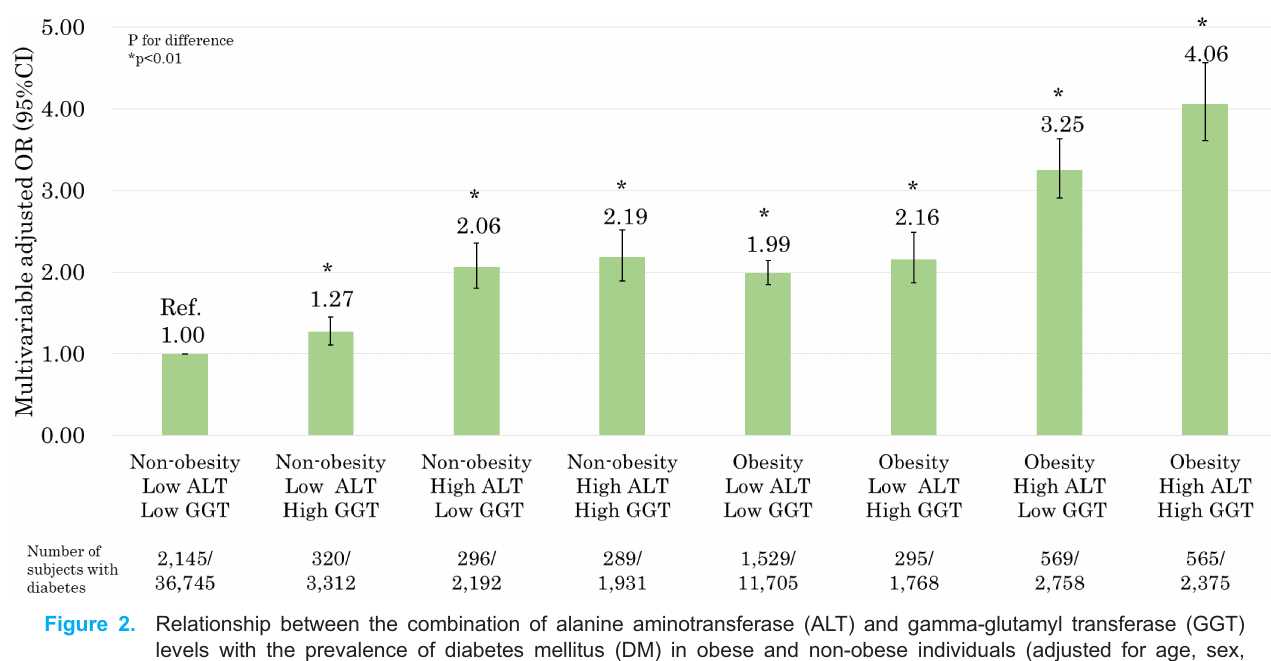
Figure 1. Relationship between the combination of alanine aminotransferase (ALT) and gamma-glutamyl transferase (GGT) levels with the prevalence of diabetes mellitus (DM) (adjusted for age, sex, body mass index [BMI], smoking status, alcohol drinking status, family history of diabetes, hyper- triglyceridemia, high low-density lipoprotein [LDL], low high-density lipoprotein [HDL], hyper- tension, physical activity, and area). P values for di ff erence were derived from multiple logistic regression analysis. Bars represent 95% con- fi dence intervals.